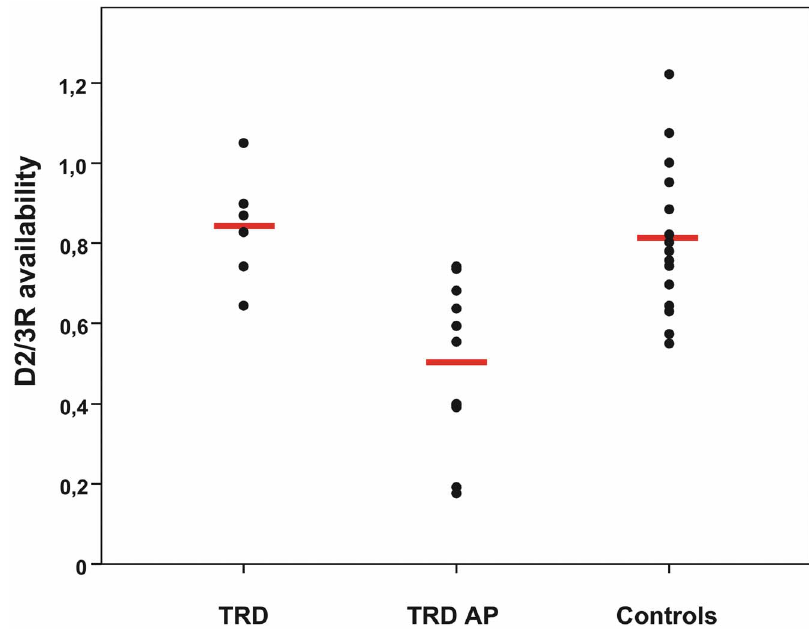
Figure 2. Striatal D2/3R availability for TRD, TRD AP and healthy control subjects. Striatal D2/3 receptor (D2/3R) availability of TRD patients, TRD patients with antipsychotics (TRD AP) and healthy control subjects. The black dots represents the striatal D2/3R availability of each subject. The horizontal lines indicate the mean D2/3R availability of each group which is 0.84 for the TRD, 0.50 for the TRD AP and 0.81 for the healthy control subjects.